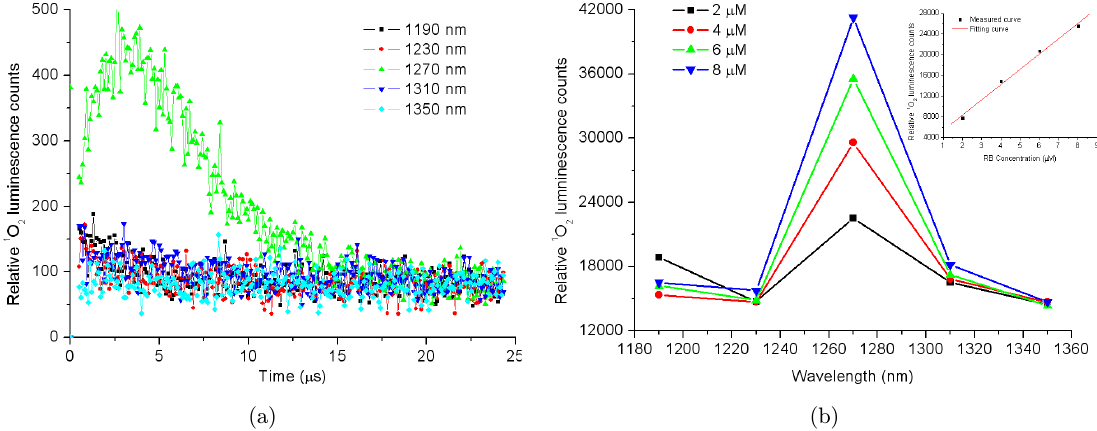
Fig. 5. (a) Temporal- and (b) spectral-resolved 1 O 2 luminescence for RB in distilled